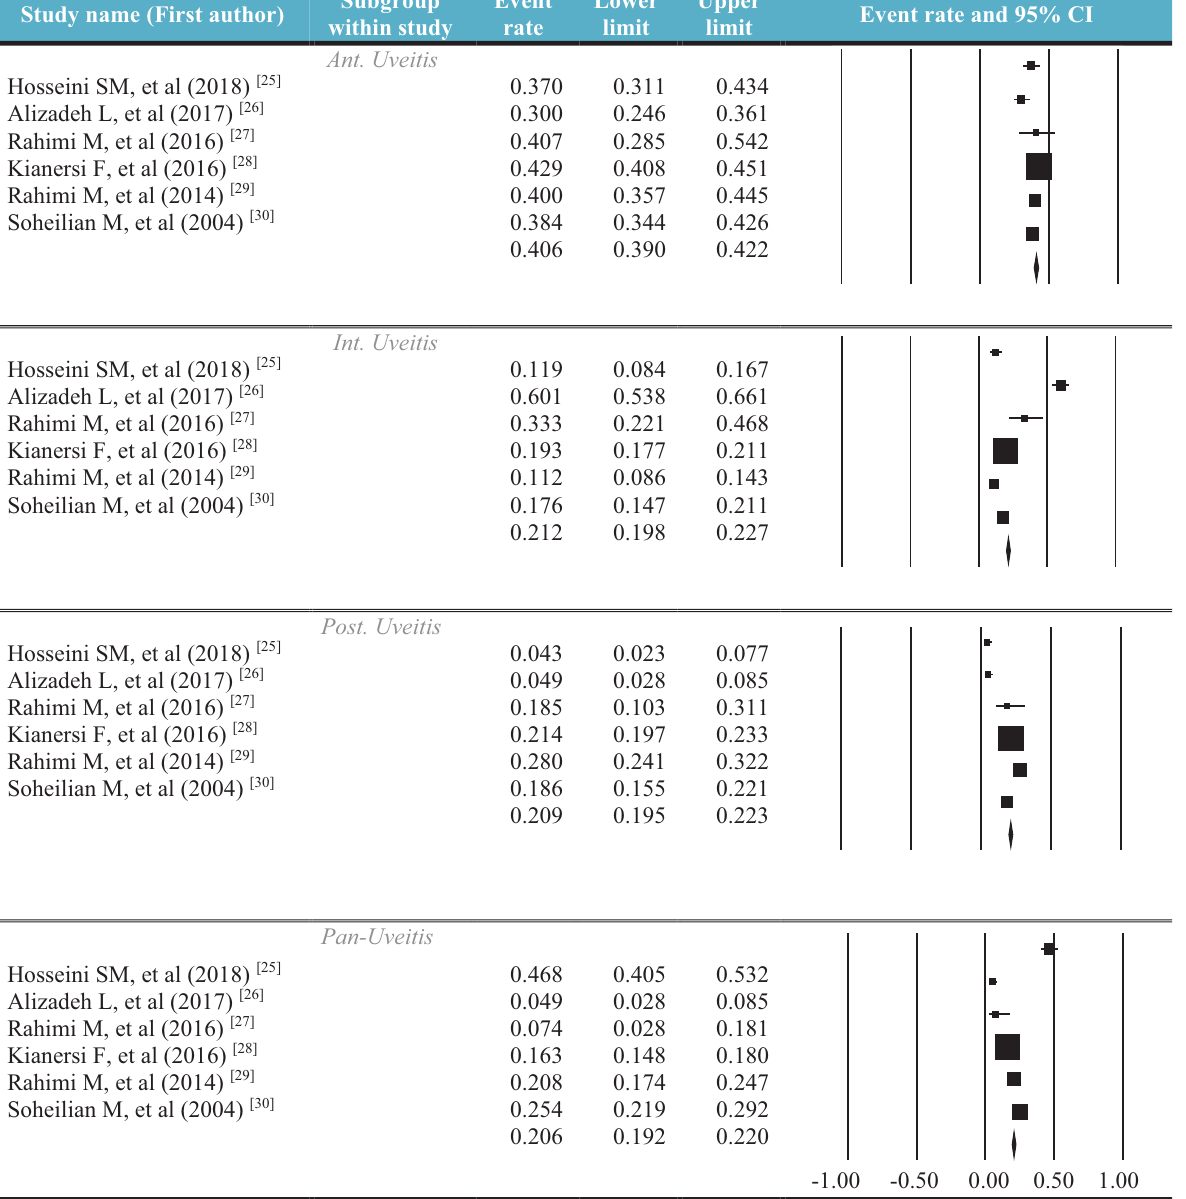
Figure 2. Pattern of uveitis based on anatomical location of involvement explained in this figure according to the studies separately. Ant. uveitis: anterior uveitis; Int. uveitis: intermediate uveitis; Post. uveitis: posterior